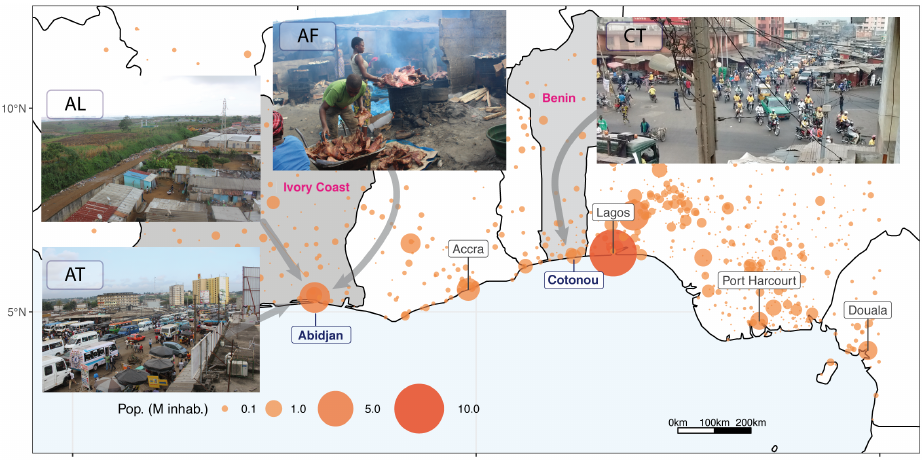
Figure 1. Localization of Abidjan and Cotonou in West Africa. Insets show the sampling sites (AT: Abidjan traffic, AL: Abidjan Landfill, AF: Abidjan fireplace and CT: Cotonou